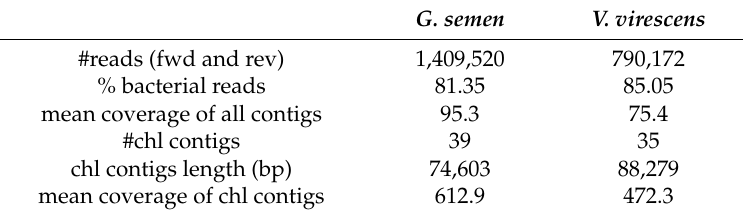
Table 1. Sequencing statistics of chloroplast (chl) samples from G. semen and V. virescens . G. semen V.